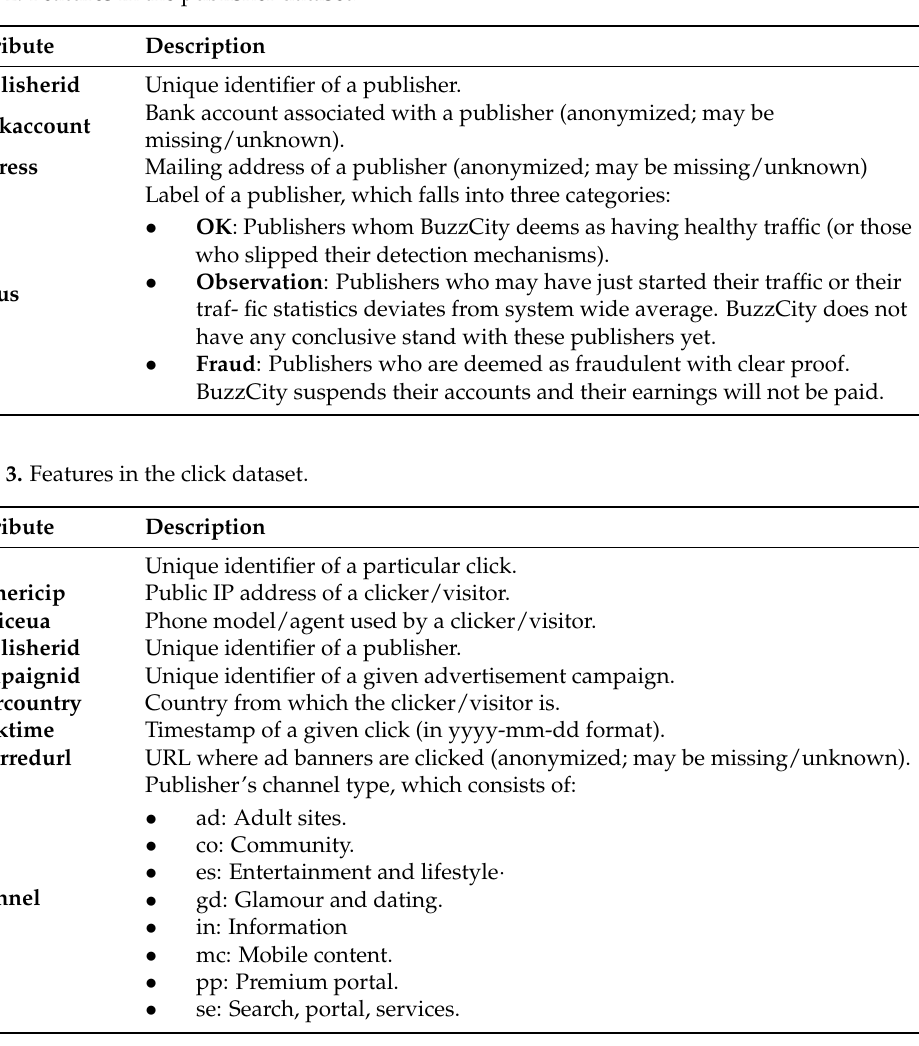
Table 2. Features in the publisher dataset.